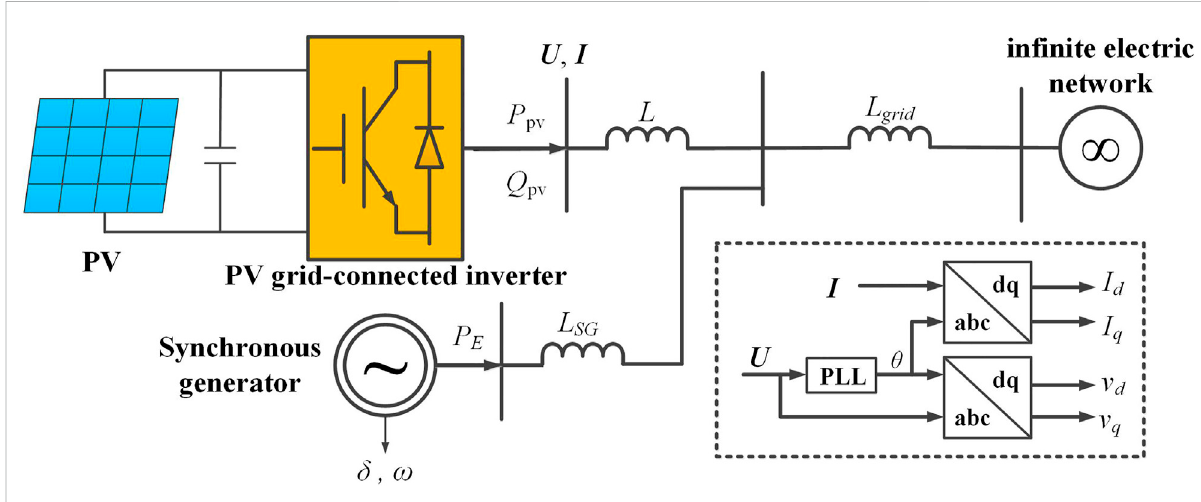
FIGURE 1 Power grid with a PV grid-connected system.